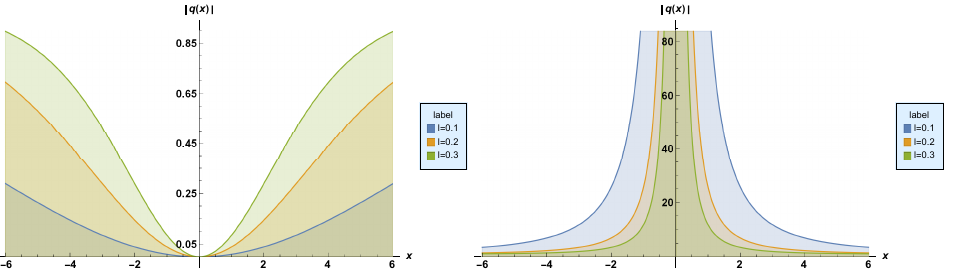
Figure 4. Profiles of stationary dark and singular solitons,